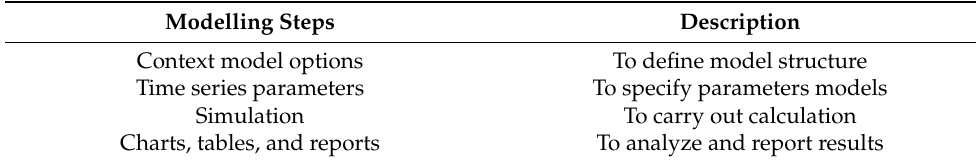
Table 2. Modeling Steps in NORM and LegacY Site Assessment code.